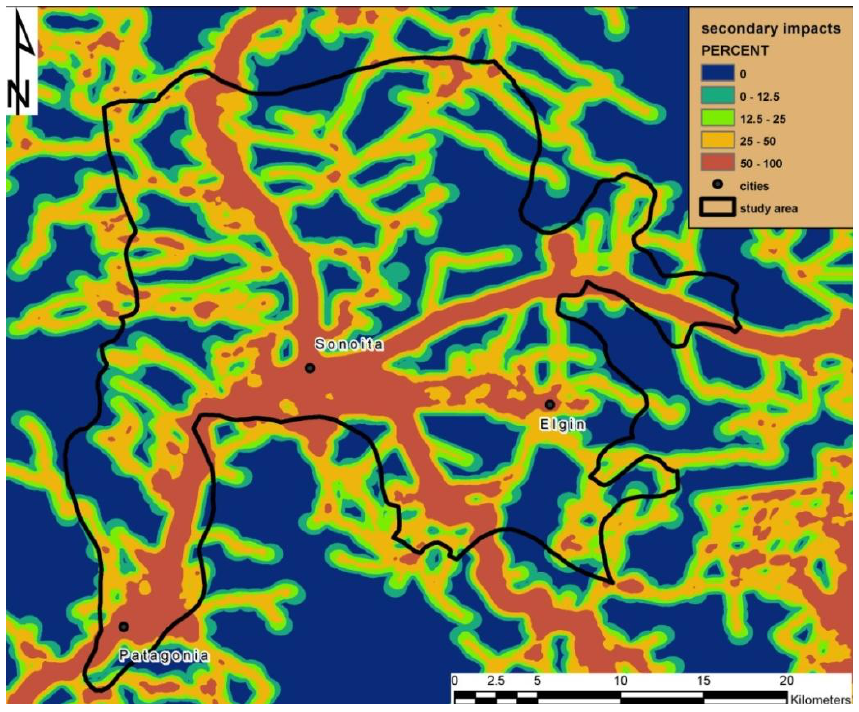
Figure 4. Cumulative impacts of houses and roads on ecosystem function. The impacts represent the area within a 500-m circular neighborhood that lies within the impact zone of a house, road or